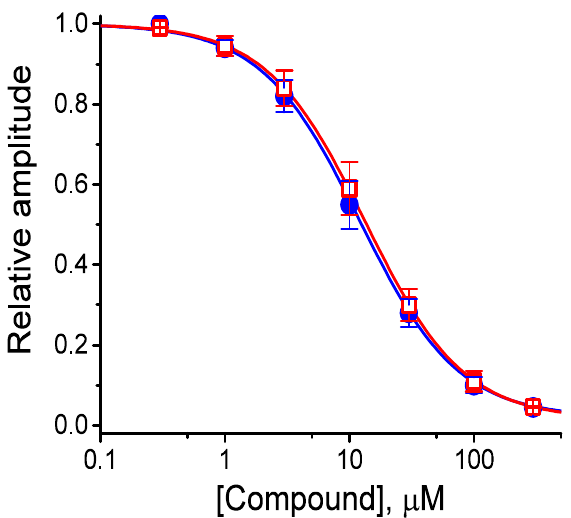
Figure 3. Concentration-response curves for HBA- and GAS-induced inhibition of I K(M) amplitude in GH 3 cells. Each cell was held at − 50 mV and depolarizing pulses to − 10 mV were applied for 1 s. The amplitude of I K(M) measured at the end of each depolarizing pulse from − 50 to − 10 mV during cell exposure to different concentrations (0.3–100 µM) of HBA or GAS were compared with the control value (mean ± SEM, n = 11 for each point). Each smooth line was fitted by a modified Hill function as detailed in the Materials and Methods Section. The values of IC 50 in the presence of HBA ( ● blue) and GAS ( □ red) were estimated to be 12.1 and 19.4 µM, respectively.